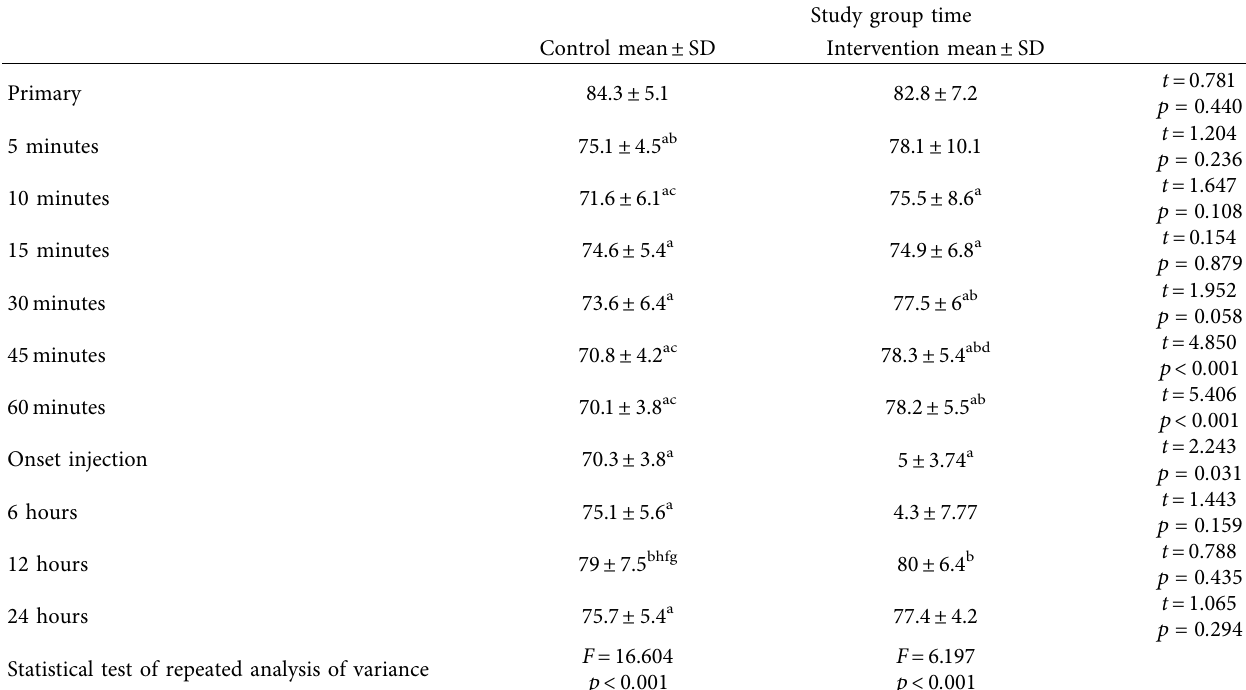
Table 4: Comparison of mean diastolic blood pressure of two groups at diferent